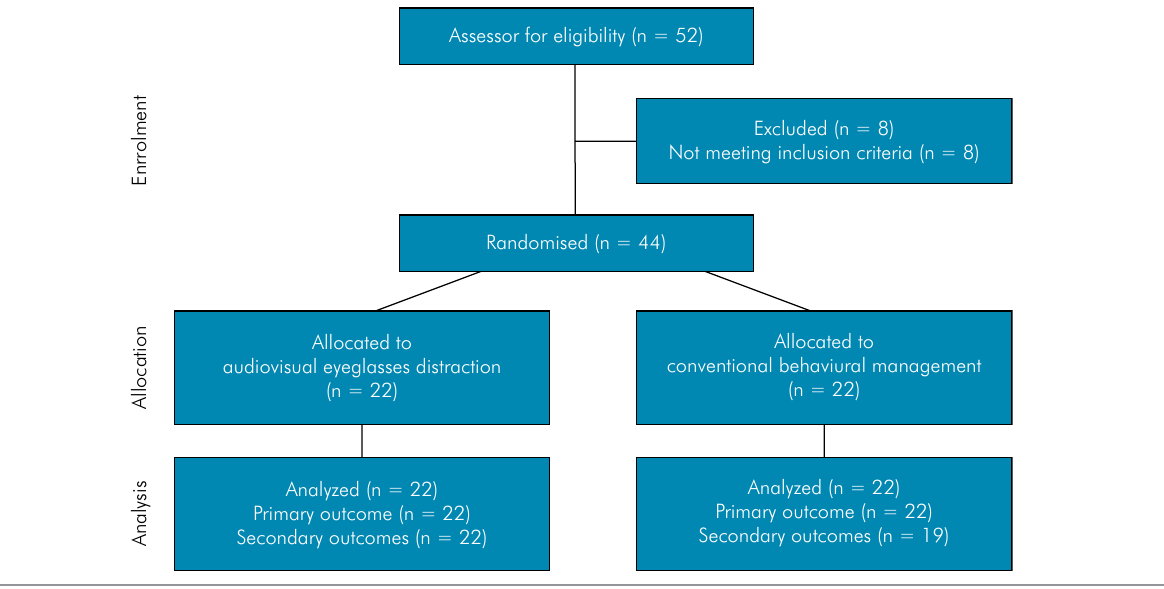
Figure 1. Flowchart of the participants